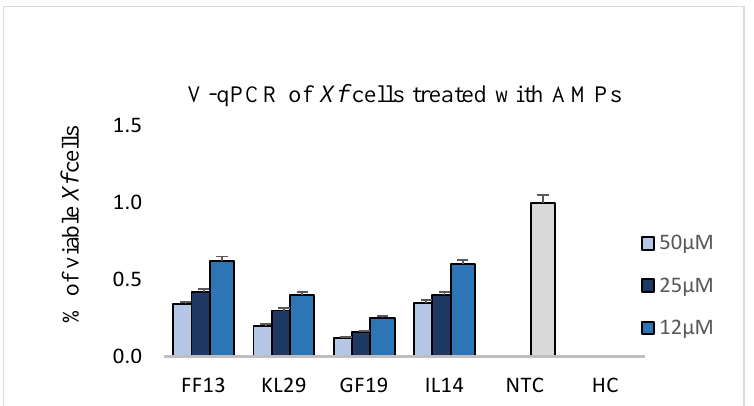
Figure 3. Viability of AMP-treated Xylella fastidiosa cells at 12, 25, and 50 µM. NTC and HC are untreated and heated Xf cells, respectively.